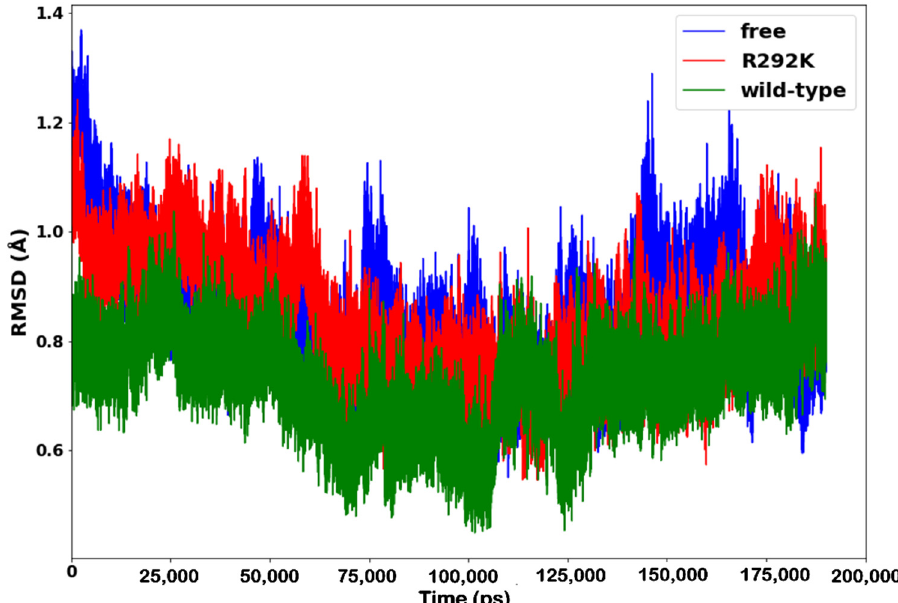
Figure 3. RMSD plot of C- α atoms of peramivir-free neuraminidase and peramivir–wild-type and peramivir–R292K neuraminidase complexes over simulation time (ps).